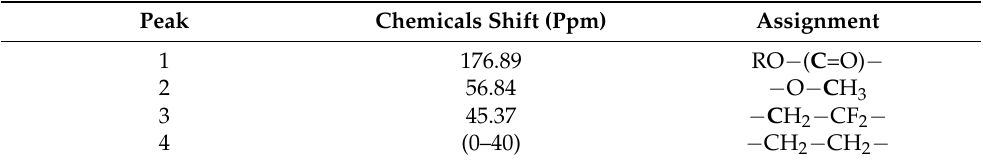
Figure 11. 13 C{ 1 H} CP − MAS NMR spectrum of Fluo AQ film. Table 6. Assignment of the chemical shift of 13 C{ 1 H} CP-MAS spectrum. Table 6. Assignment of the chemical shift of 13 C{ 1 H} CP-MAS spectrum.